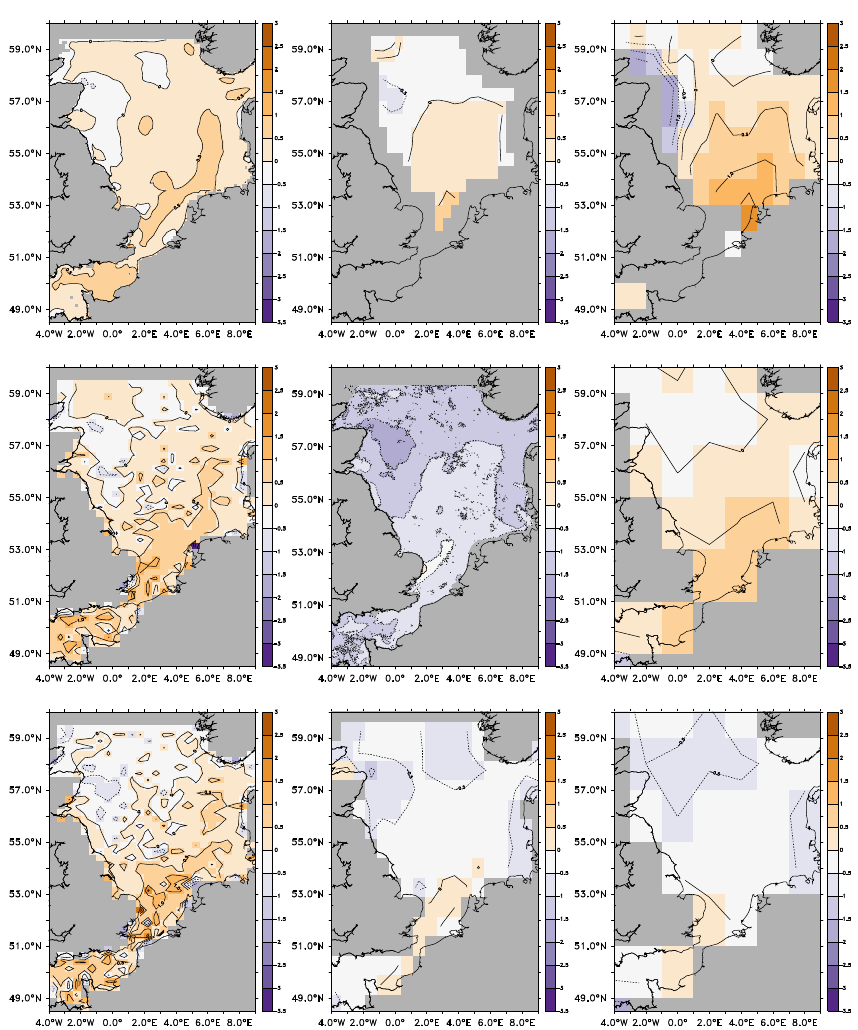
Figure 1. Climatological annual mean sea surface temperature (SST) biases ( ◦ C) of the RCA4-NEMO ERA40 hindcast relative to ICES ( upper row left ), HOAPS3 ( upper row middle ), ASMD94 ( upper row right ), KNSC (1970 to 1999) ( middle row left ), BSH SST ( middle row middle ), ERA40 (1970 to 1999) ( middle row right ), KNSC (1980 to 2009) ( lower row lef t), ERA interim (1980 to 2009) ( lower row middle ), ERA40 (1980 to 2009) ( lower row right ). The averaging periods for the model data